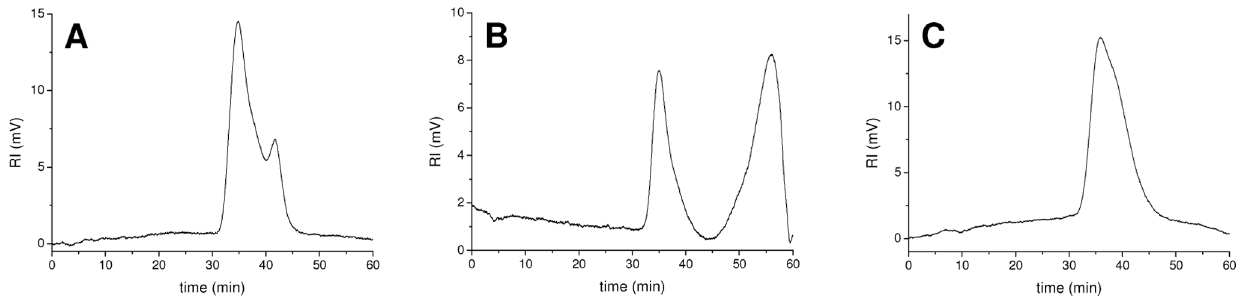
Figure 4. HP-SEC chromatograms of exopolysaccharides mixtures. EPOL mixtures produced by B. multivorans C1576 (A), B. vietnamiensis (B) and B. cenocepacia 18829